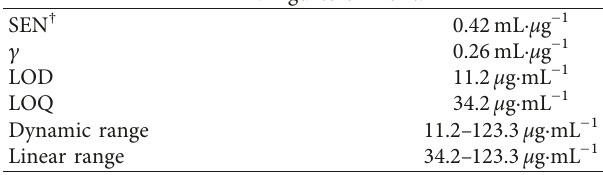
Table 4: Figures of